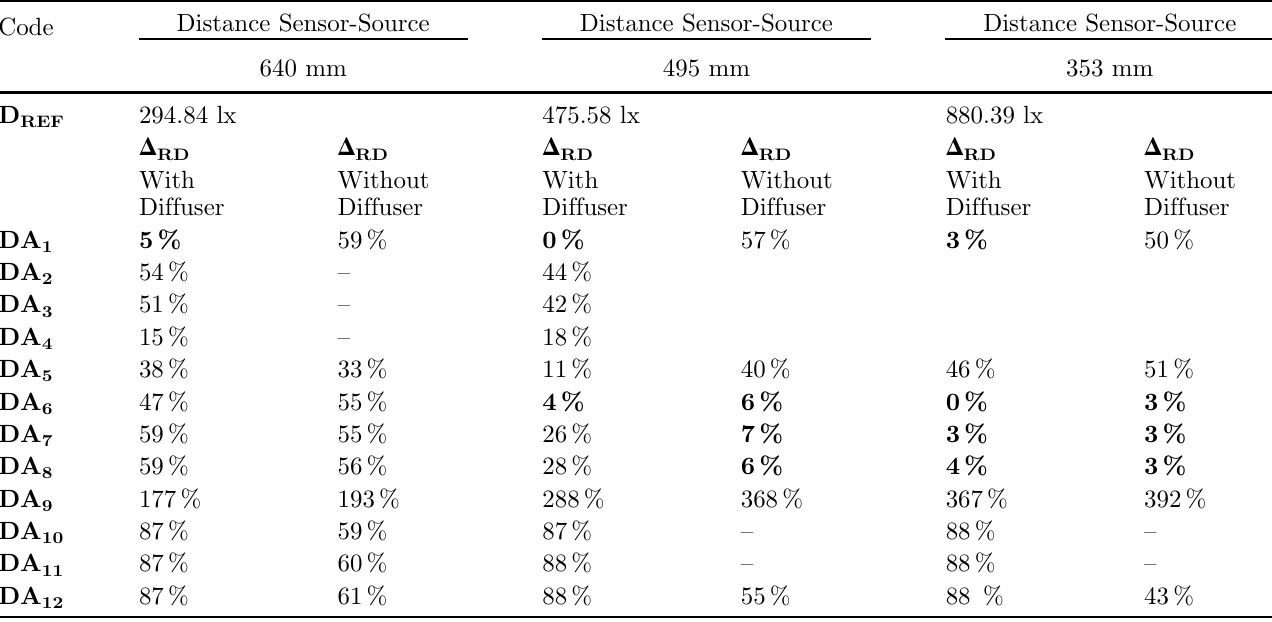
Table 2. Relative percentage difference ( D RD ) between mean values of the mobile ’ s results and the reference value for the three illuminance levels at each sensor-light source